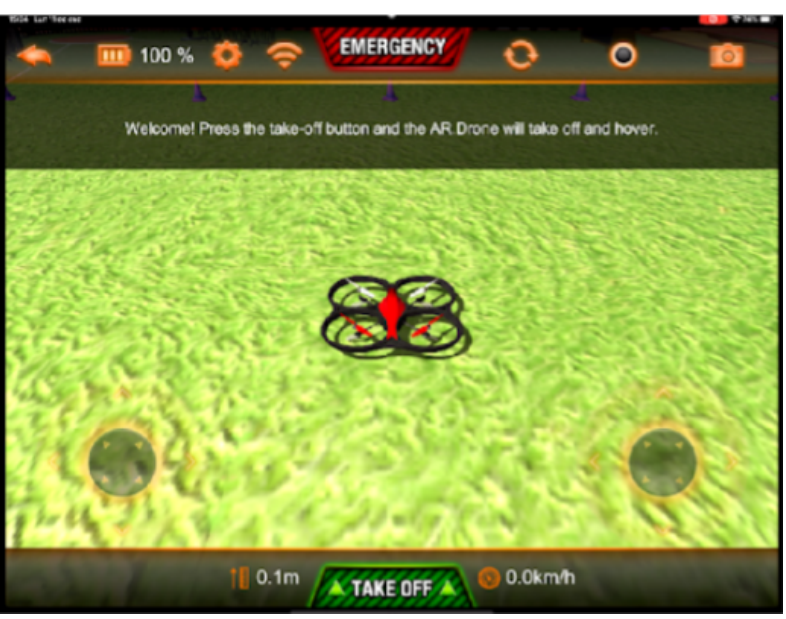
Figure 10. Software AR Drone Sim Pro Lite.